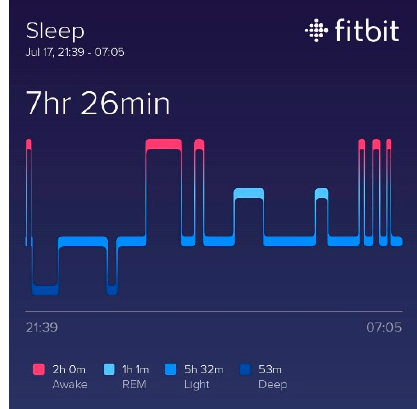
Figure A25. Dubai, UAE.